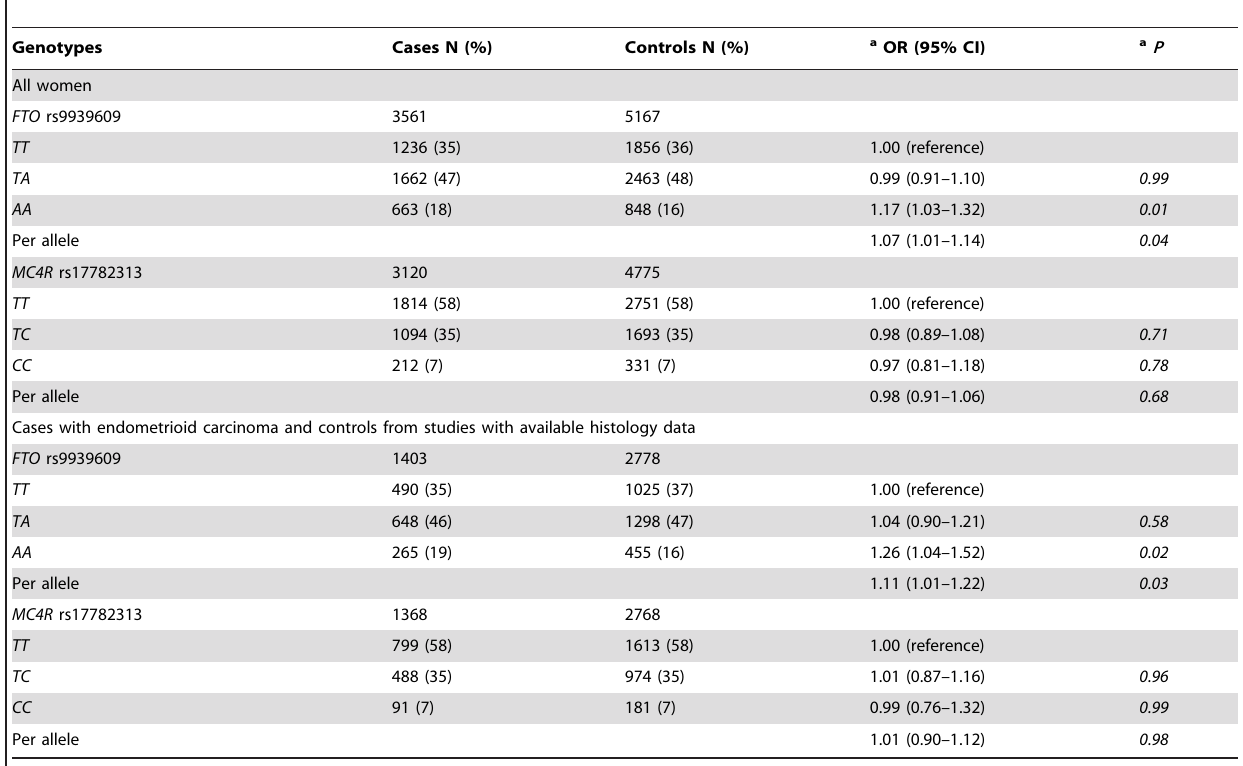
Table 2. Association of the FTO rs9939609 and MC4R rs17782313 with endometrial carcinoma risk.